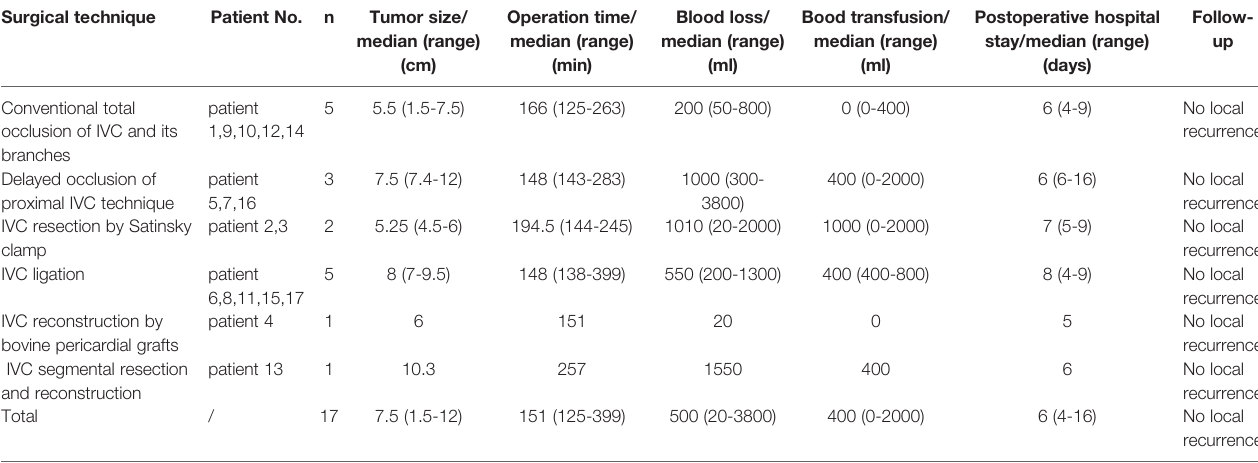
TABLE 2 | Comparison between different surgical technique groups on parameters and outcomes. Surgical technique Patient No.